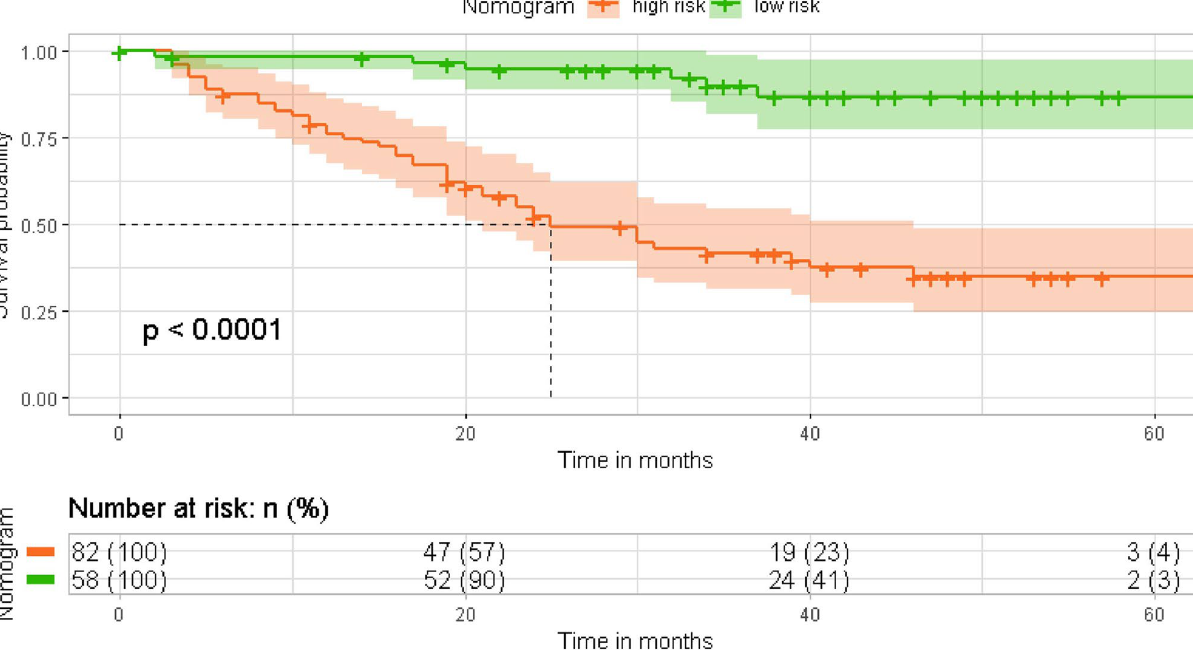
Fig. 5 Survival curve of risk stratification for OS based on prediction of nomogram. Patients in high-risk group had short survival. Low risk: total points ≤ 100. High risk: total points > 100. OS overall